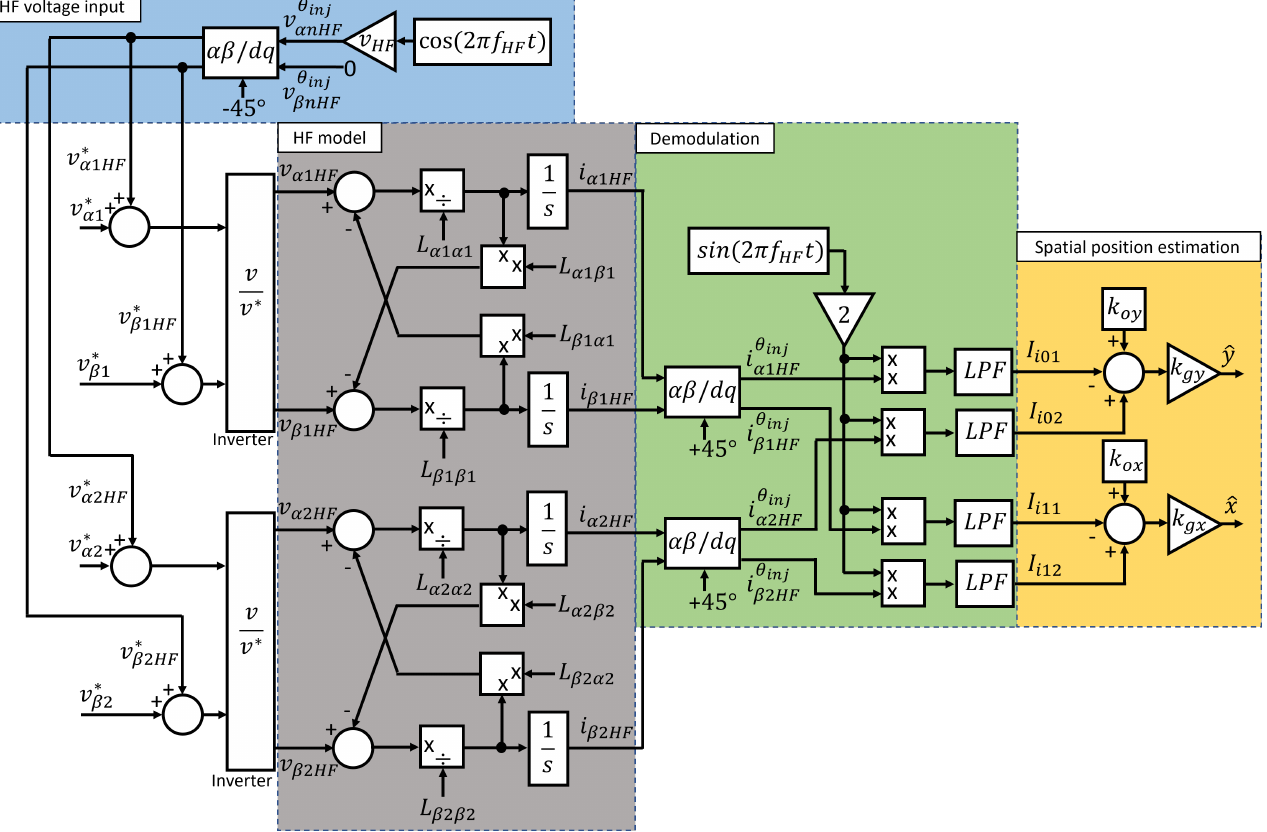
Figure 10. xy -position self-sensing block diagram, HF voltage injection in between αβ -axes (blue), HF model of the self-bearing machine (gray), HF current demodulation block diagram (green), and xy -position estimation block diagram